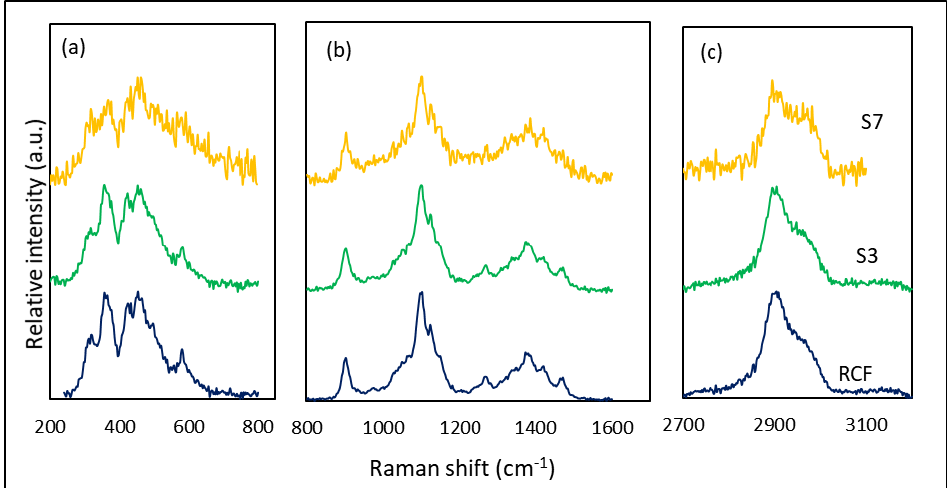
Figure 8. Raman spectra of virgin RCF compared to fibers at different stages of the electroless plating process, at three different spectral intervals. ( a ) 200–800 cm −1 , ( b ) 800–1600 cm −1 , and ( c ) 2700–3200 cm −1 . All peaks are normalized to the maximum peak value at the respective interval; peaks were shifted vertically for presentation purposes.